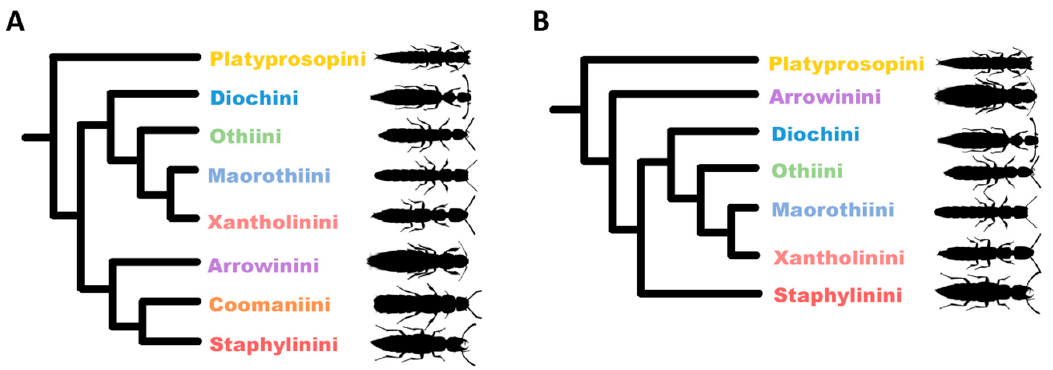
Figure 2. Summary of competing hypotheses on the intertribal relationships within Staphylininae showing the uncertain position of the tribe Arrowinini. ( A ) Topology recovered by reanalyzing data from ˙Zyła and Solodovnikov [21] with a site-heterogeneous CAT-GTR model (Figure 1). ( B ) Topology recovered by reanalyzing data from Cai et al. [3] with a site-heterogeneous CAT-GTR model. Note that Coomaniini was not sampled in the latter